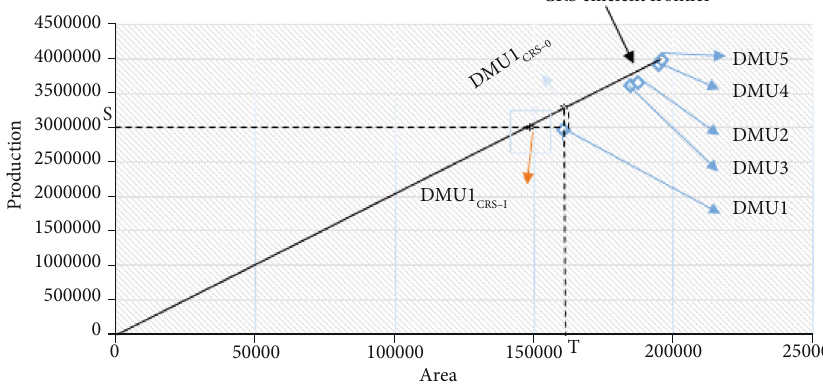
Figure 2: DEA dealing relative e ffi ciency scale (TES).